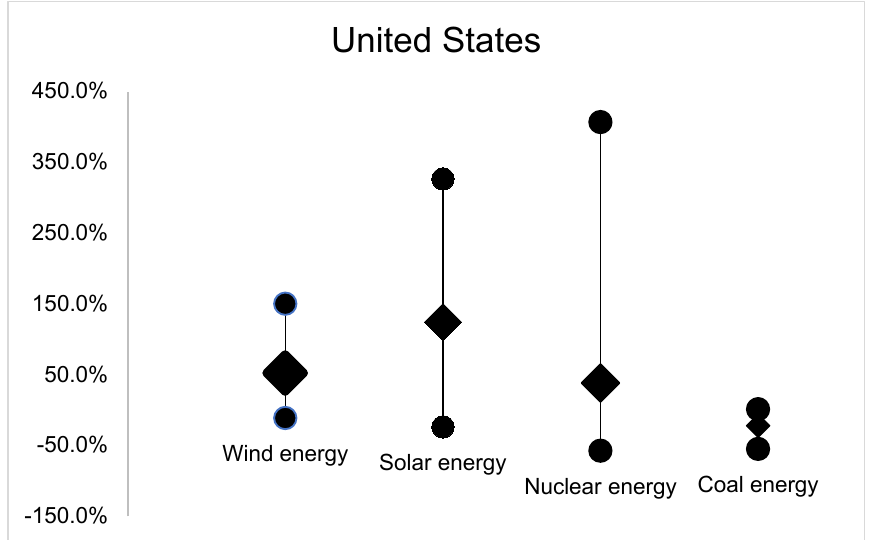
Figure 10. Willingness to pay for various types of electric energy in the United States . Source: own study.